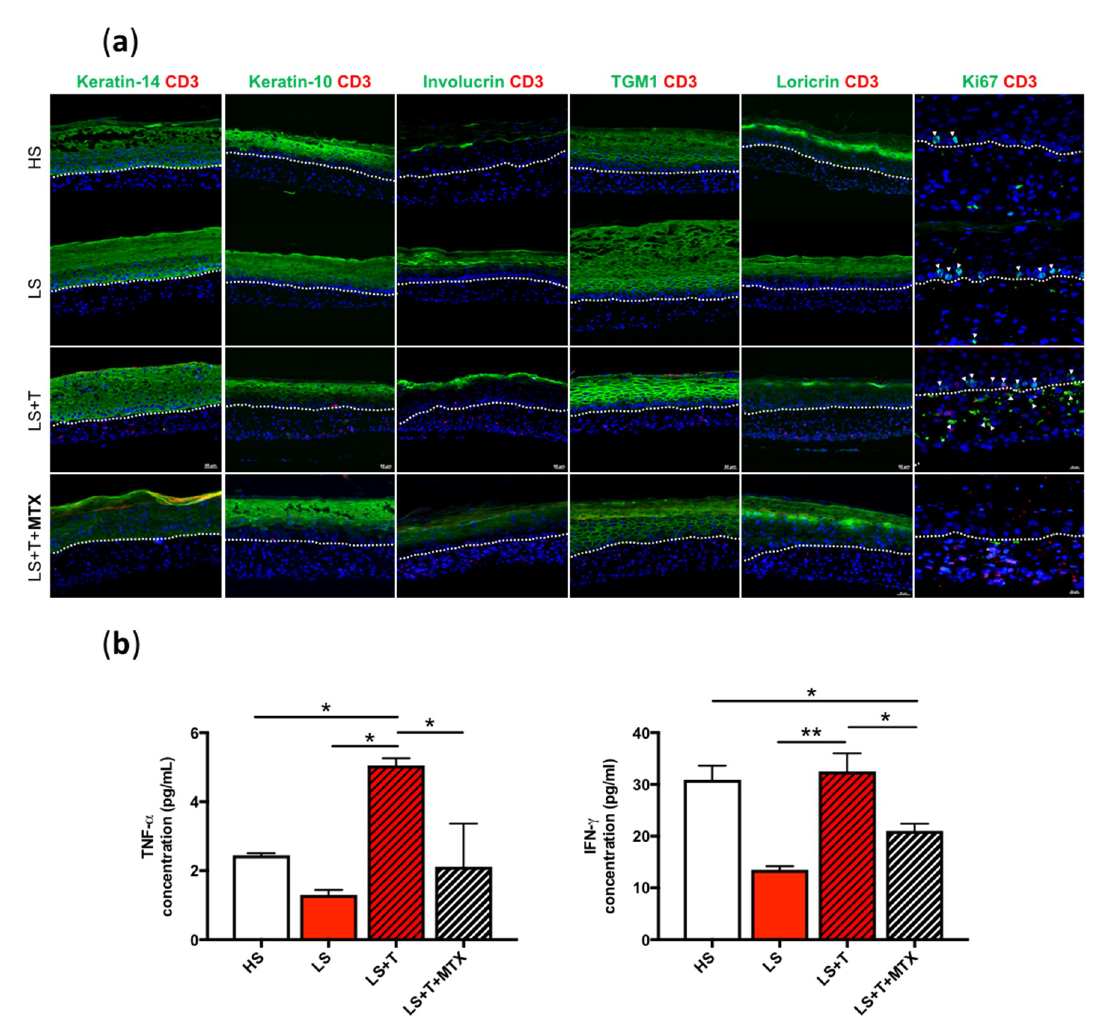
Figure 6. Alleviation of the epithelial phenotype and decrease in the production of TNF-α and IFN-γ after methotrexate treatment. ( a ) Expression of keratin-14, keratin-10, involucrin, transglutaminase 1 (TGM1), loricrin, and Ki67 (costained with DAPI) monitored by immunofluorescence in healthy (HS), lesional (LS), and immunocompetent lesional skin models treated (LS + T + MTX) or not (LS + T) with methotrexate (MTX). Dashed white lines represent the basement membrane. Scale bar = 50 μm. ( b ) Protein expression analysis of the culture supernatants of healthy (HS), lesional (LS), and lesional with T cells (LS + T) skin models, with (LS + T + MTX) or without (LS + T) methotrexate treatment, at day 21 of the air-liquid culture, assessed with Luminex xMap technology. The values are presented as mean ± SD ( n = 3). Significant differences (* p < 0.05, ** p < 0.01) are indicated by an asterisk.